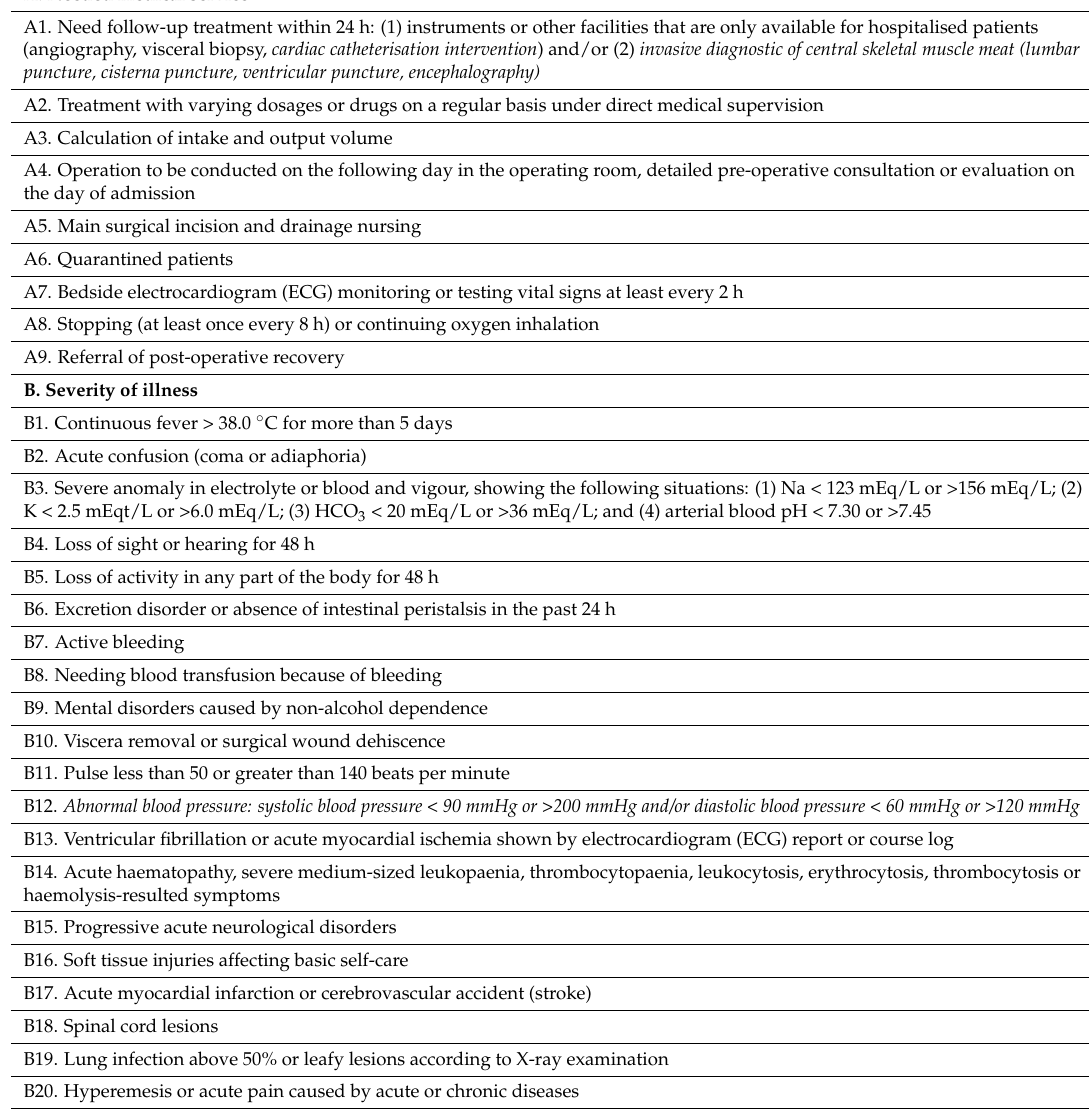
Table 1. Appropriateness evaluation protocol (AEP) criteria for county